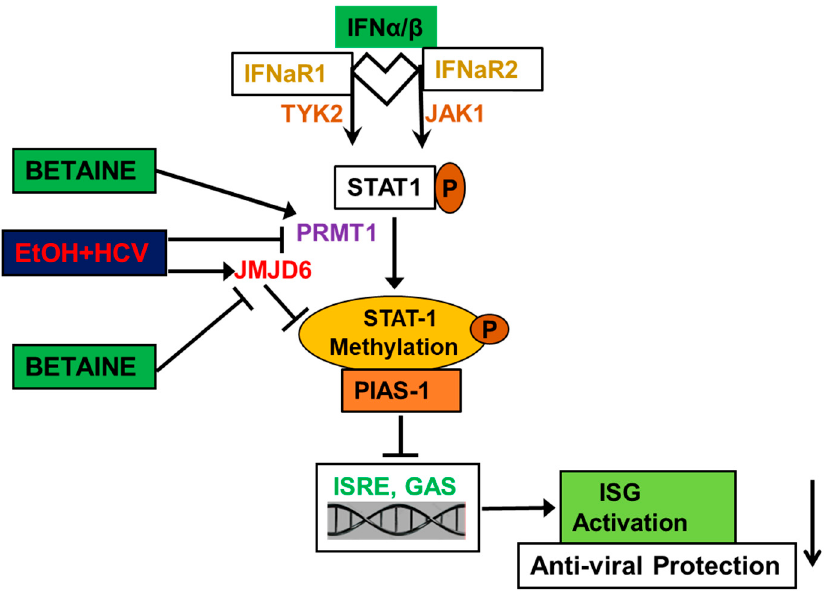
Figure 3. Schematic representation for effects of betaine on HCV and ethanol-mediated innate immunity.